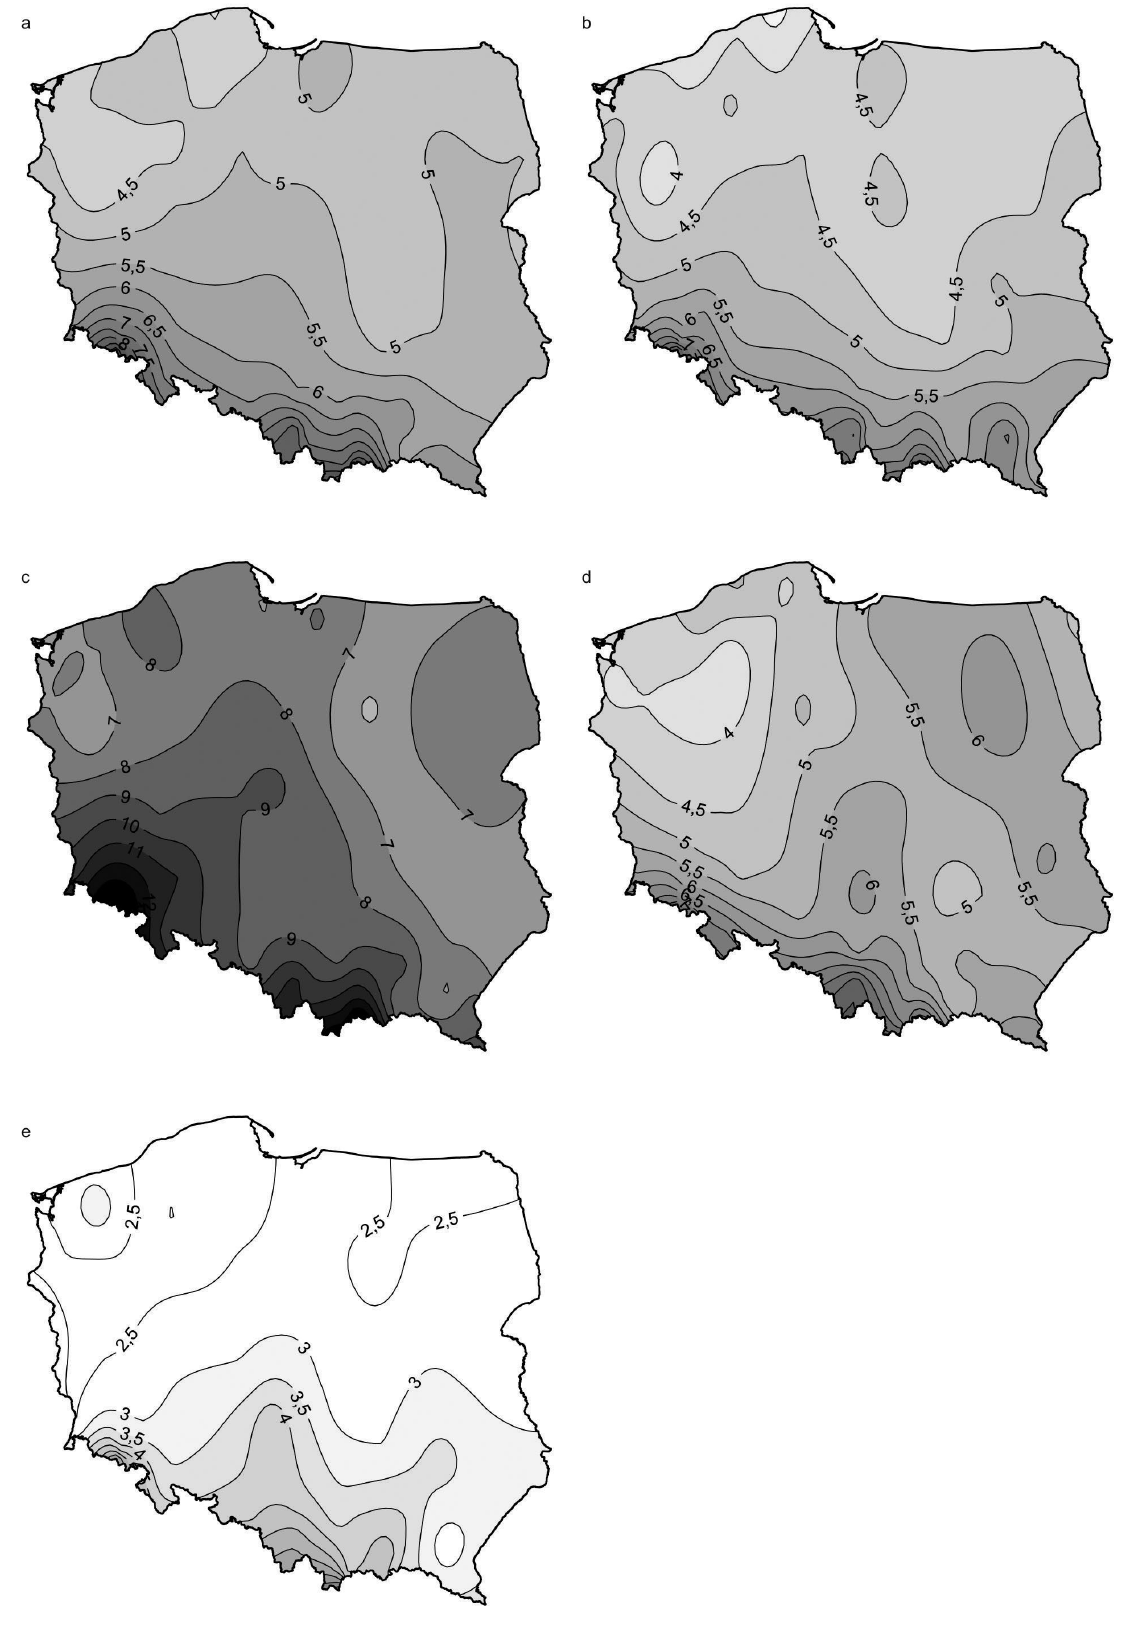
Fig. 6. Mean MCP intensity in Poland [mm day -1 ] in 1958–2008 a – year, b – spring, c – summer, d – autumn, e –